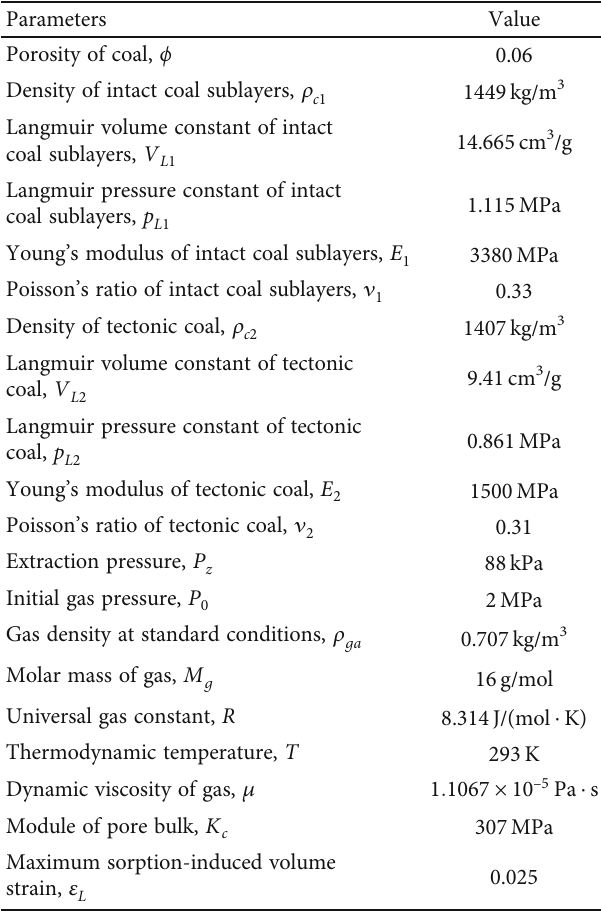
Table 1: Constant parameters used in the simulation model.